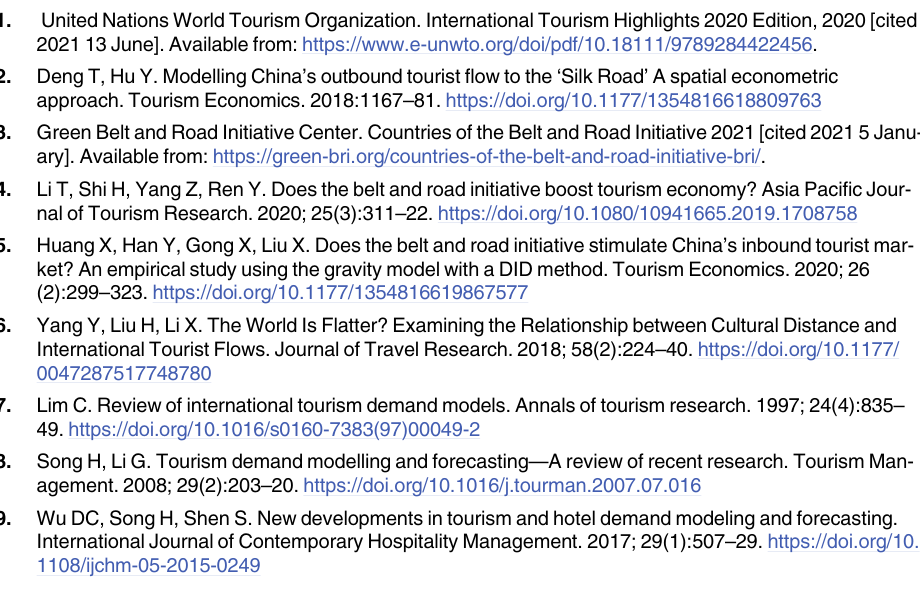
S1 Table. Summary of tourism studies related to the BRI. (PDF) S2 Table. List of the BRI countries/regions by the end of 2018.